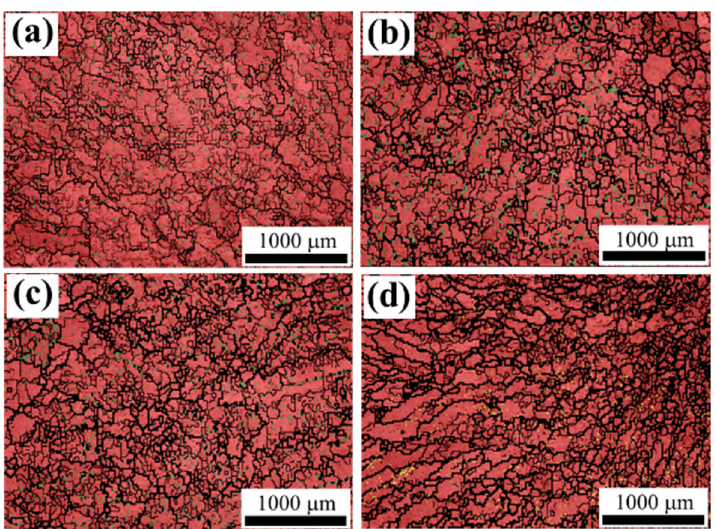
Figure 8. Grain morphology of ingot center at different cooling rates: ( a ) 1.69 °C/s; ( b ) 2.01 °C/s; ( c ) 5.87 °C/s; ( d ) 10.28 °C/s.